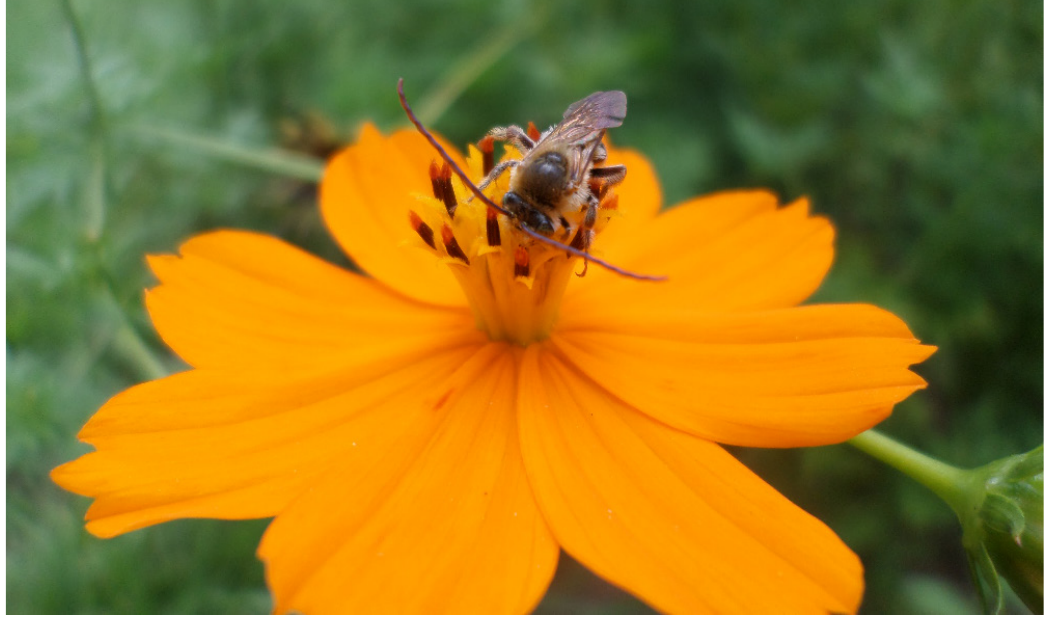
Fig 3. Male of Melissodes nigroaenea ingesting nectar in flower of Cosmos sulphureus .